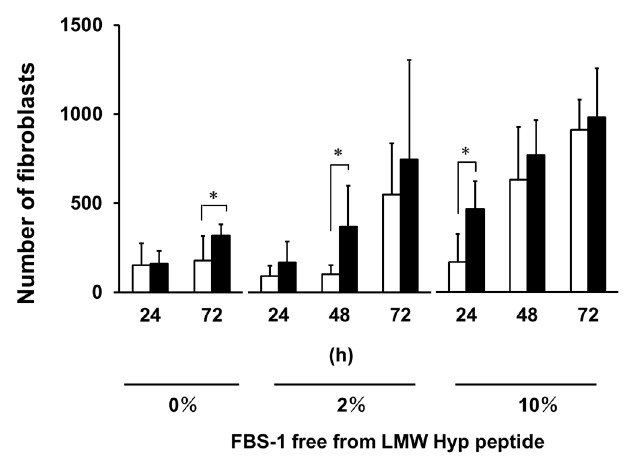
Figure 6. Effect of Pro-Hyp on the number of fibroblasts migrated from mouse skin in the absence or presence of FBS-1 free from LMW hydroxyprolyl peptides. Open column, control; closed column, medium containing Pro-Hyp at 200 µM. Data are shown as the mean ± SD ( n = 6). Asterisks indicate significant differences ( p < 0.05, Student’s t -test).